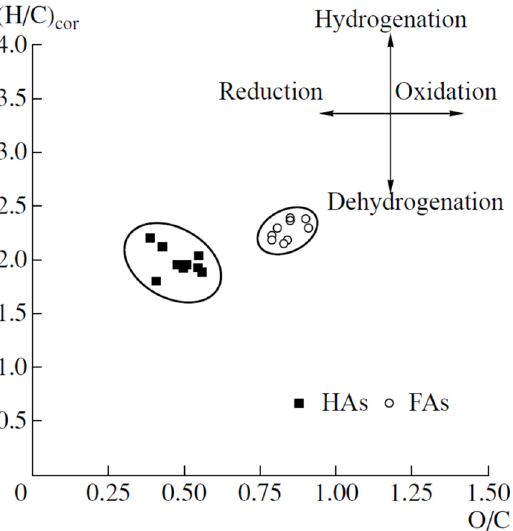
Figure 1. Distribution of preparations by atomic ratio in the (H/C) cor – O/C coordinates.